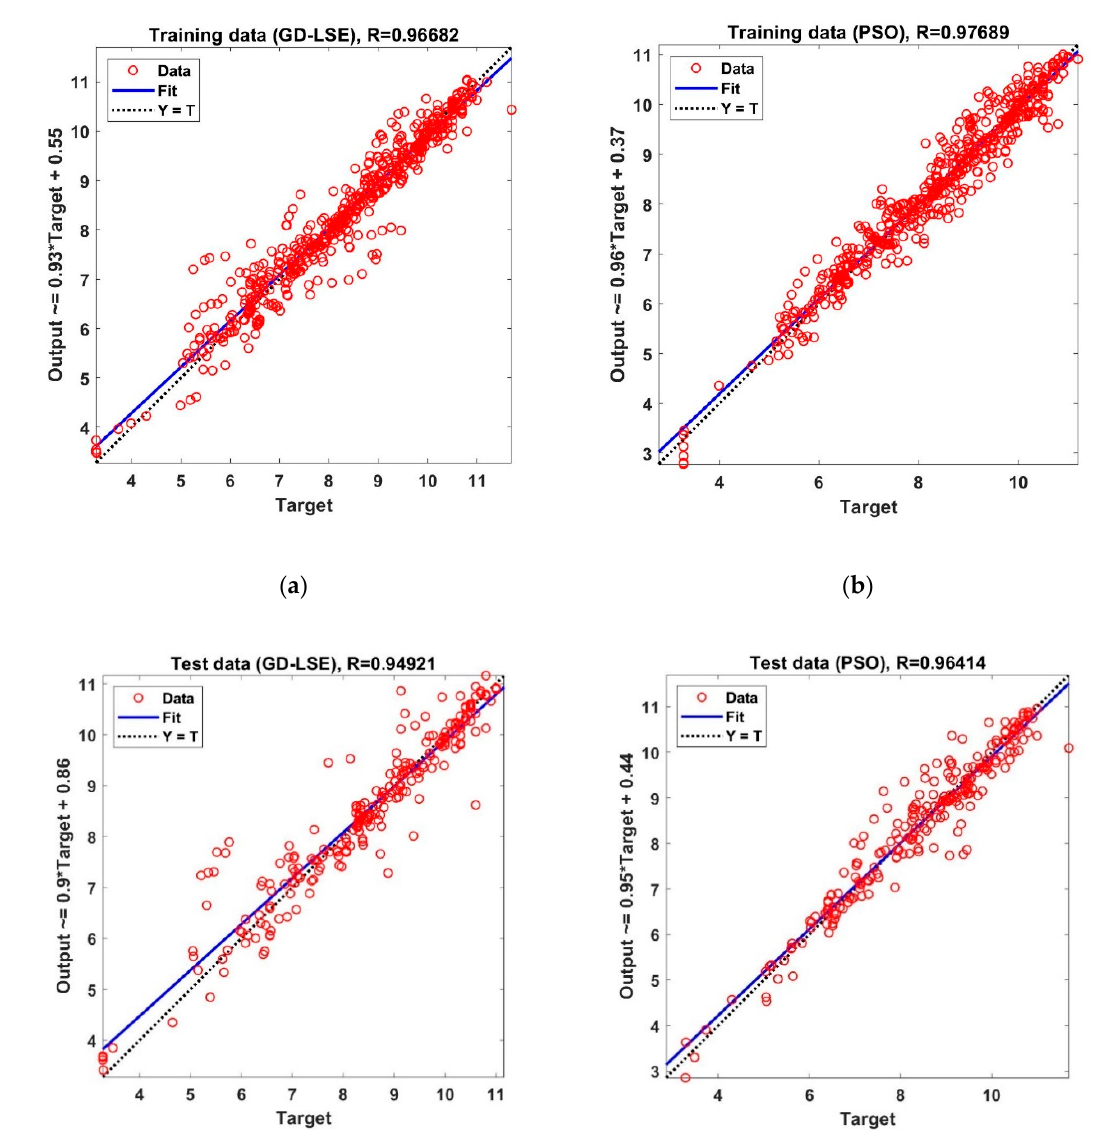
Figure 8. Comparison of regression plots between GD-LSE ANFIS and PSO ANFIS model predictions of the evaporator outlet pressure, P r,out , using training and test data: ( a ) training data (GD-LSE); ( b ) training data (PSO); ( c ) test data (GD-LSE); and ( d ) test data